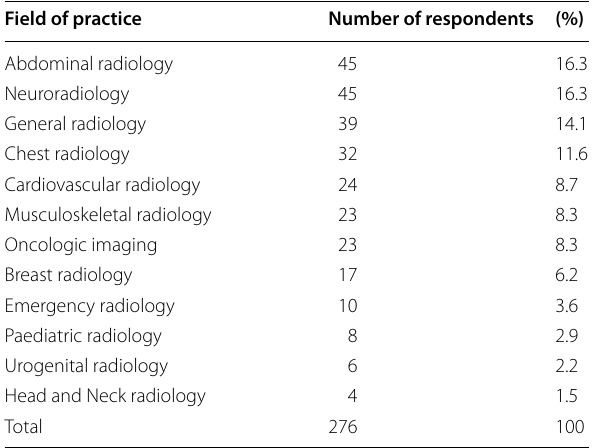
Table 4 Respondents with practical clinical experience with AI-based algorithms: Have there been any major problems with integration of AI-based algorithms into your IT system/workflow?